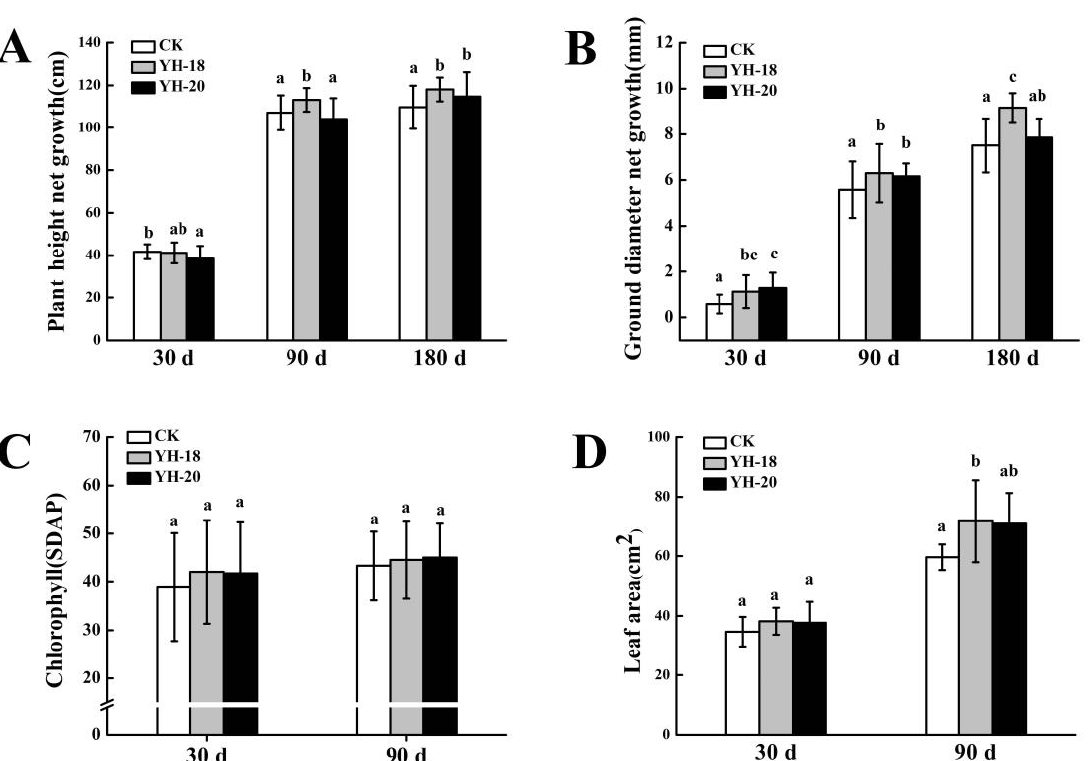
Figure 1. Effects of inoculation with YH-18 and YH-20 on ( A ) ground diameter growth, ( B ) height growth, ( C ) chlorophyll content and ( D ) leaf area of P. davidiana . Different letters indicate significant differences between different treatments in a group within the same period at a confidence level of p <